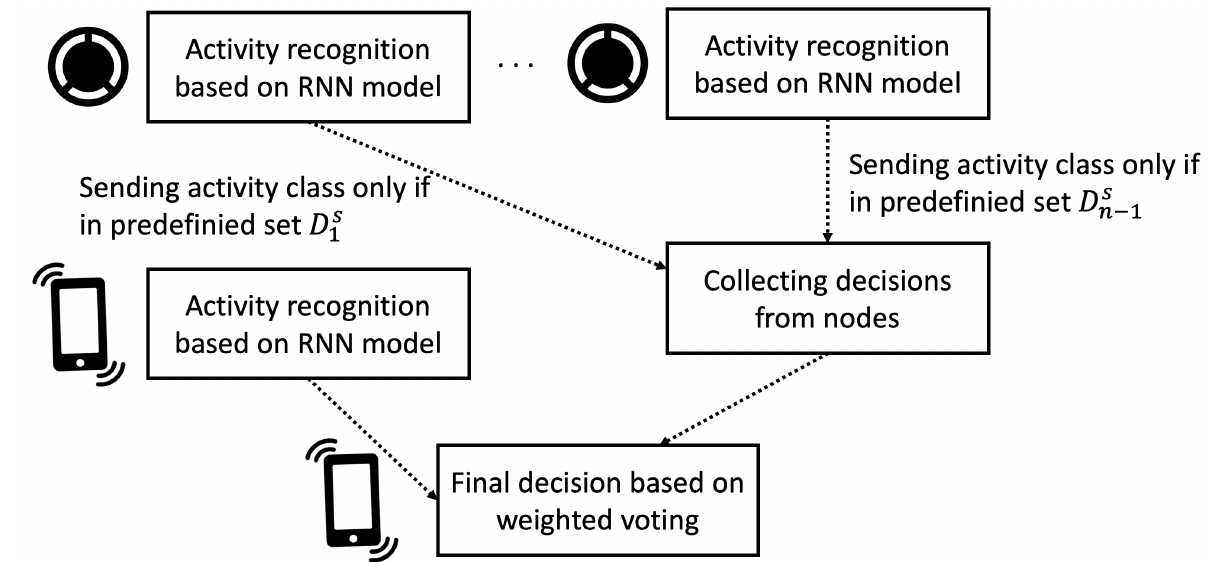
Figure 1. Overview of the proposed personal area network model for activity